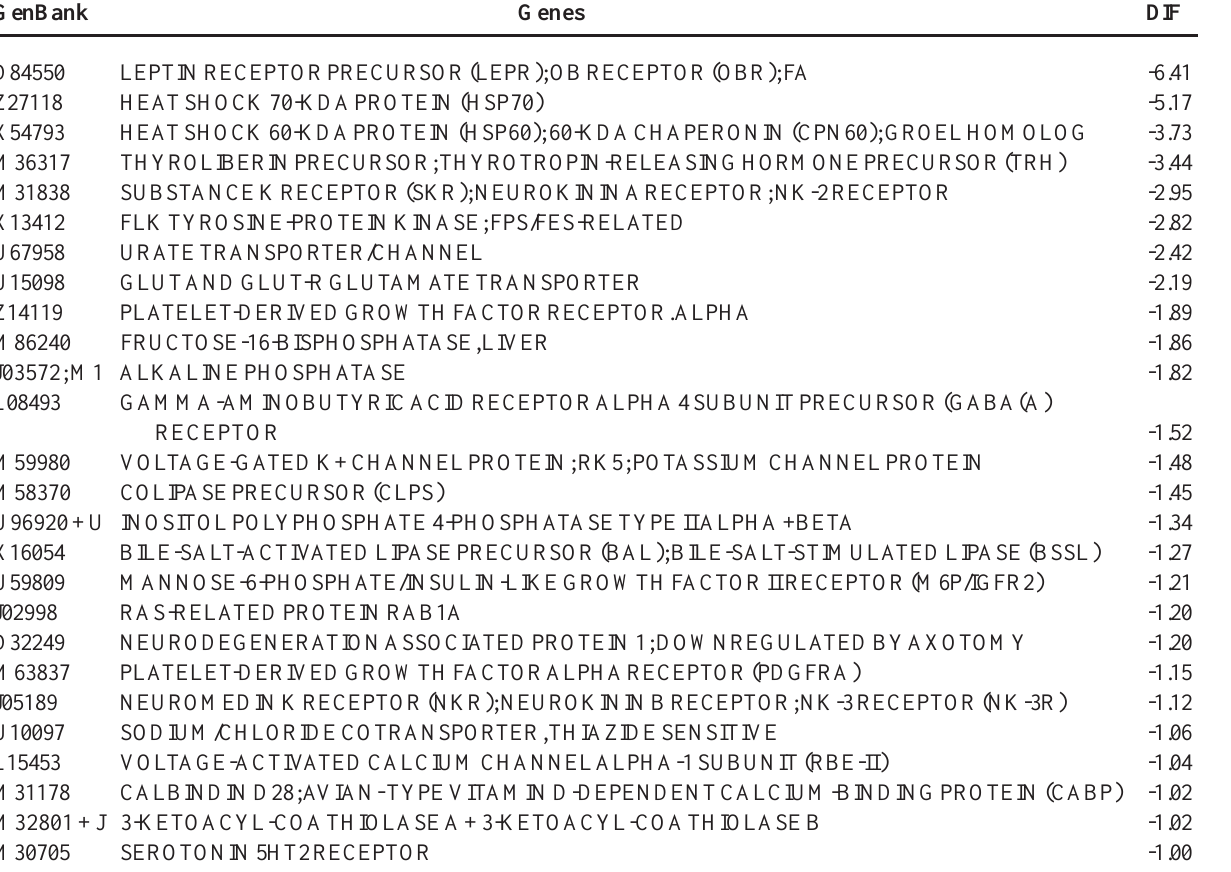
Table 1 – Genes lower expressed in Group II.